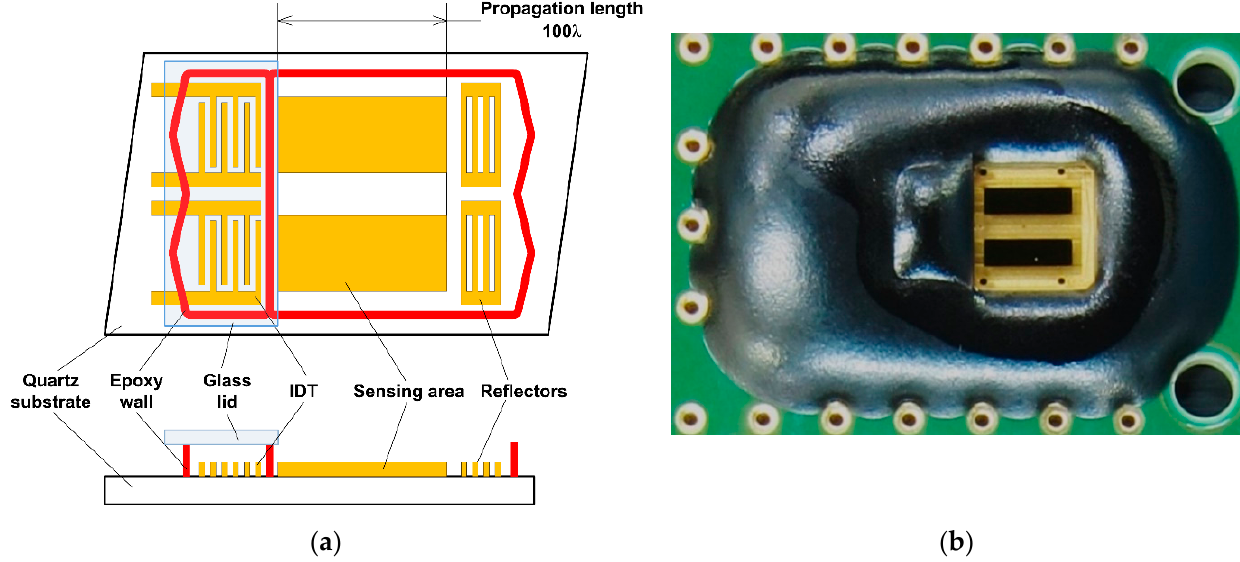
Figure 1. SH-SAW biosensor device used in this study. ( a ) Schematic of the top view and cross section; ( b ) picture of the sensor device. Only the sensing areas and reflectors are exposed; the other parts are covered with black epoxy resin. Table 2. Design parameters of the 250 MHz SH-SAW biosensor. Item